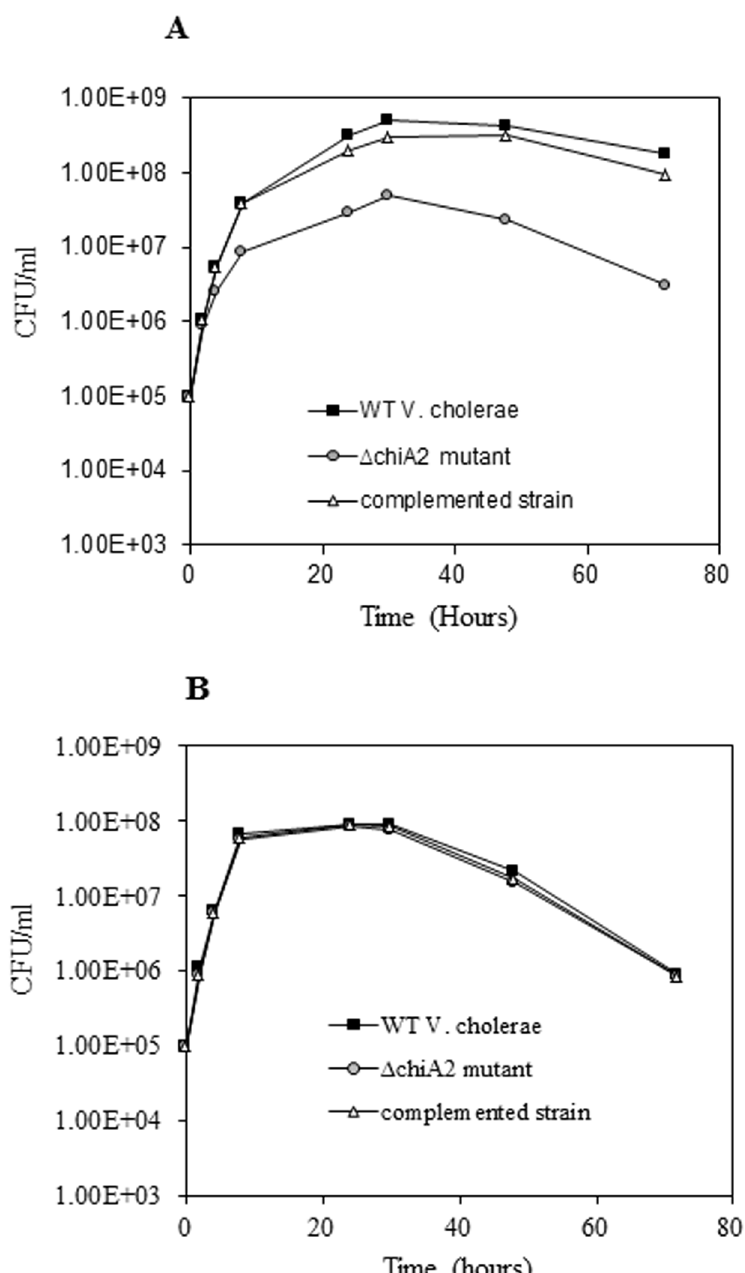
Figure 4. Utilization of mucin as nutrient for growth by V.cholerae . V. cholerae wild type, D chiA2 mutant and the complemented strain were separately grown in LB upto log phase. The log phase cultures of the wild type V. cholerae , D chiA2 mutant and the complemented strain were centrifuged and washed in PBS. The minimal media supplemented with 2% (w/v) porcine mucin and fresh LB broth were inoculated separately with equal number of washed V. cholerae wild type and D chiA2 mutant and complemented strain. The number of bacteria survived with increasing incubation time was detected by plate count method for all of the strains. The viable counts of bacteria were graphically represented. A . Viable count when mucin used as nutrient. B . Viable count when grown in LB broth. Each of the experiment was repeated thrice (n=3) and the data expressed as means 6 SEM.